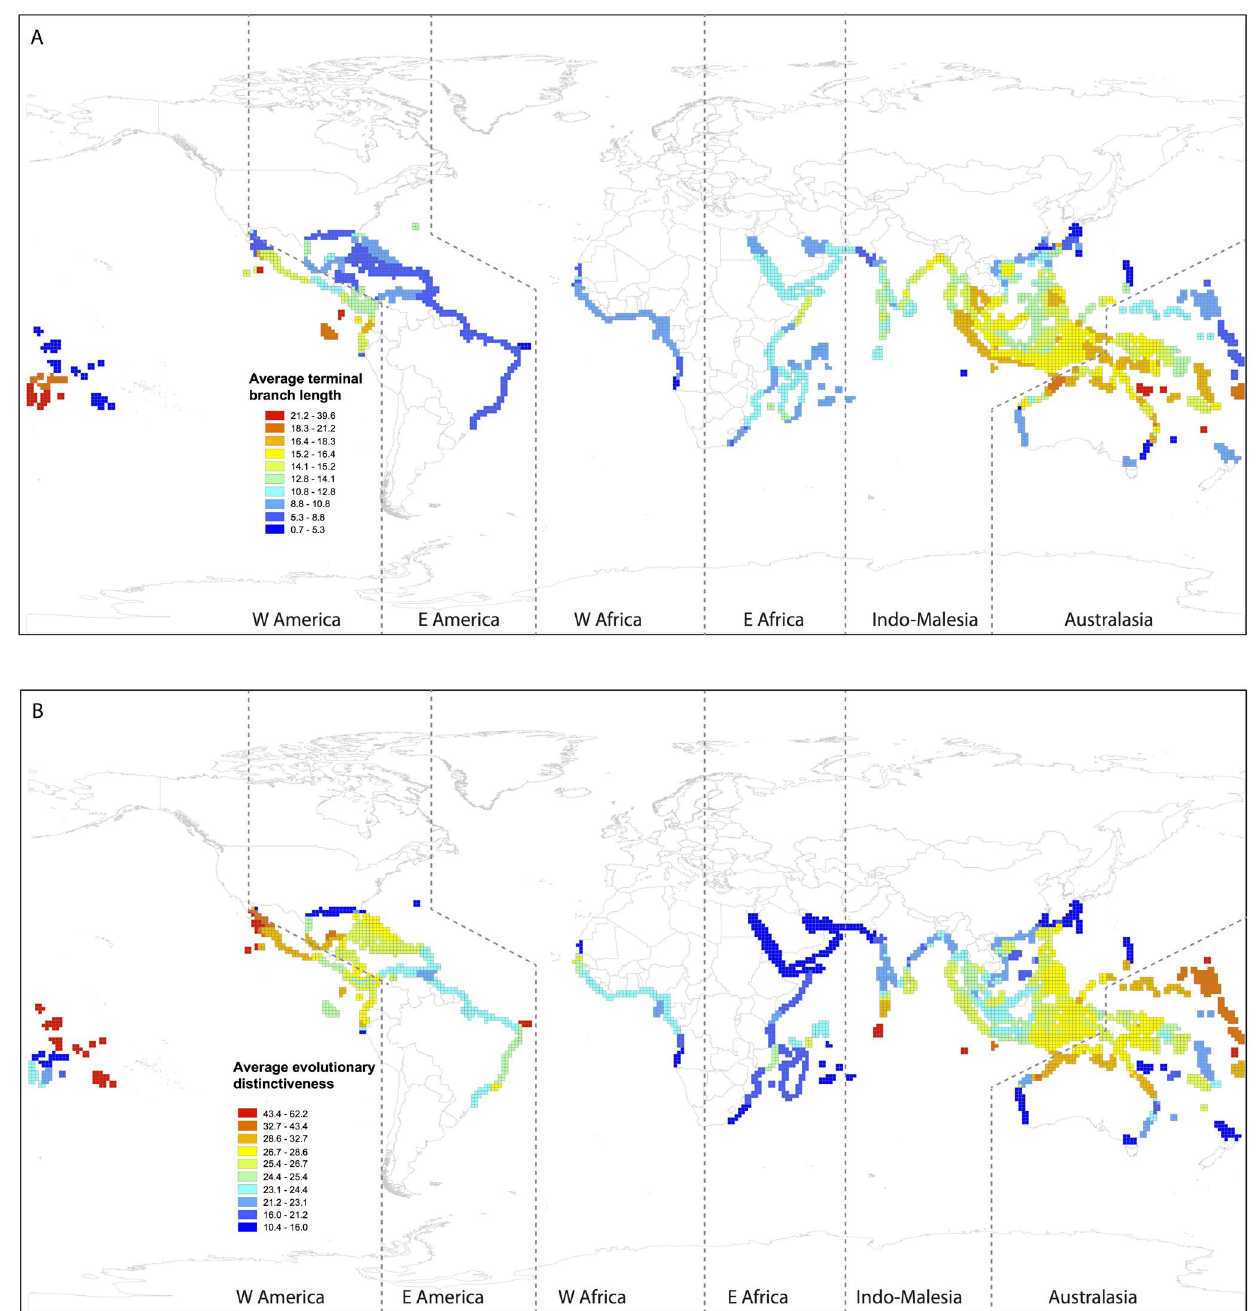
Figure 2. Geographical distribution of phylogenetic diversity within mangrove ecosystem for (A) mean terminal branch lengths, and (B) mean evolutionary distinctiveness across the same six biogeographical regions depicted in Figure 1.